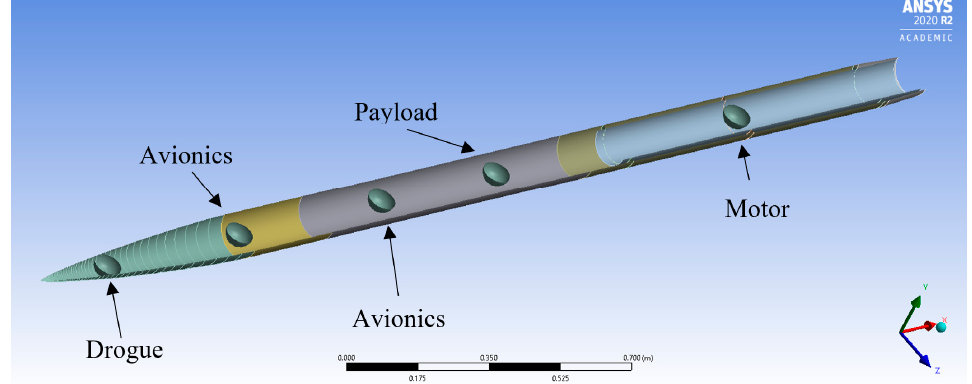
Figure 24. Annotated point mass locations within the rocket cross-section. Table 10. Motor mass and mass moment of inertia values.